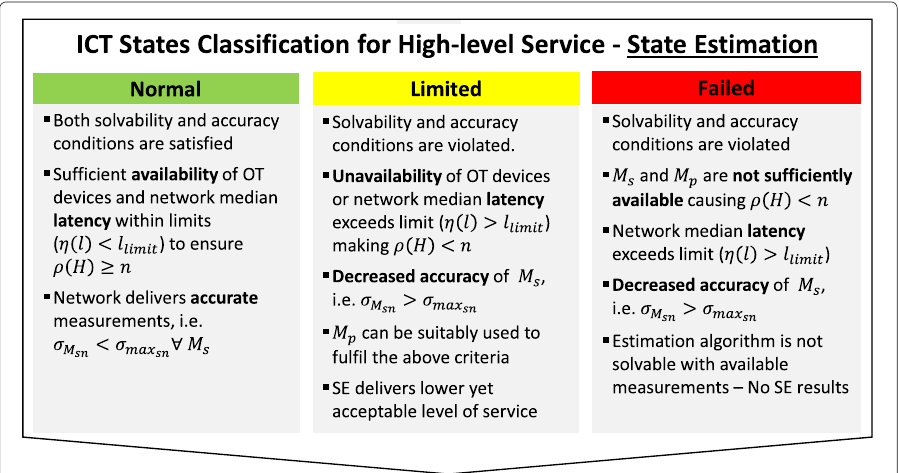
Fig. 5 ICT State Classification of High-level Service - State